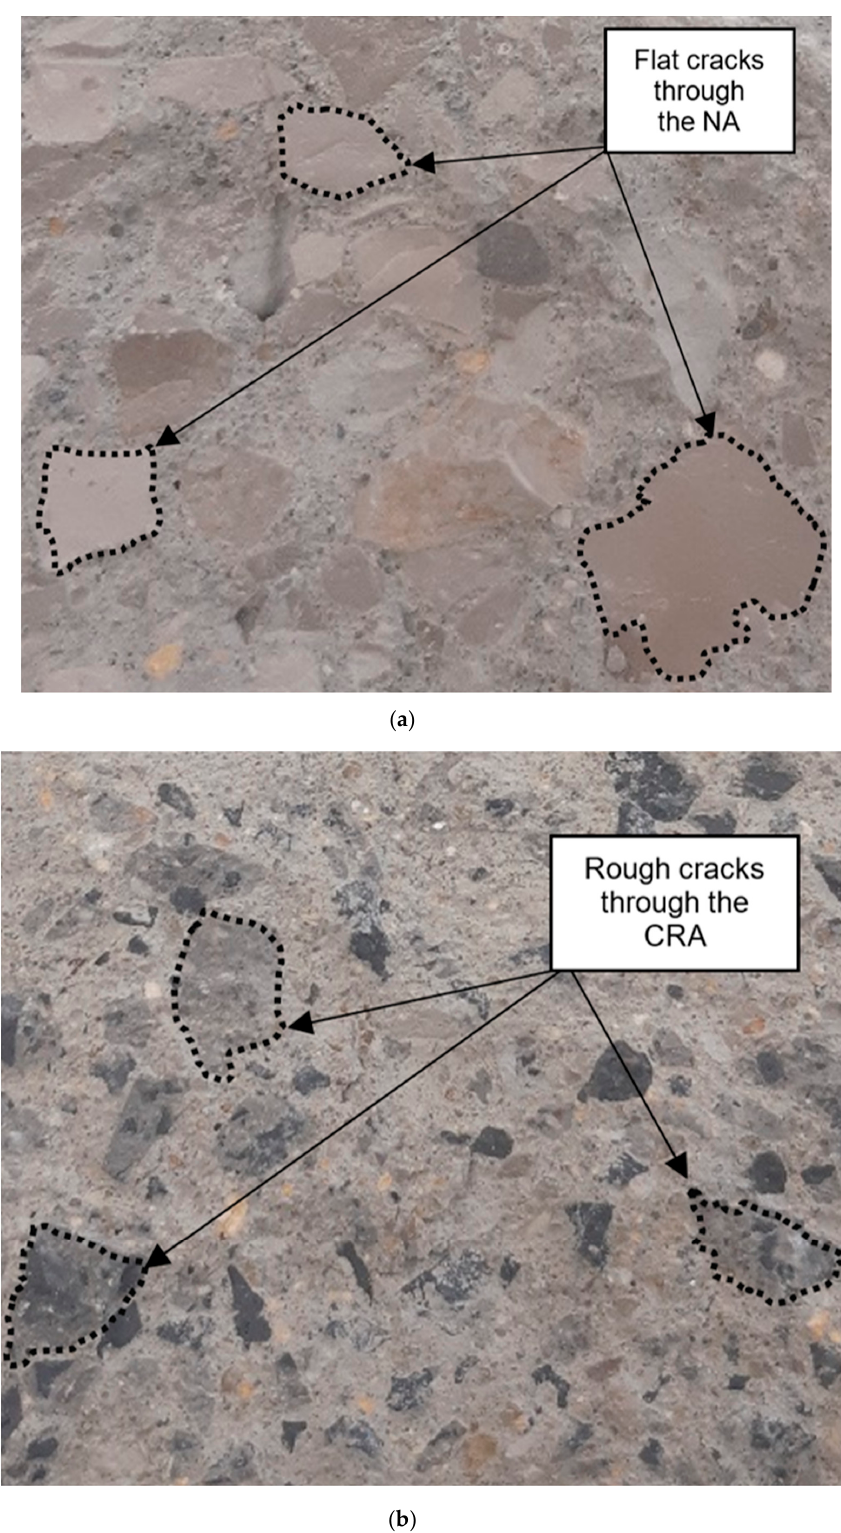
Figure 6. Crack patterns of test specimens subjected to tensile strength test for 0% ( a ) and 100% ( b ) replacement ratio.